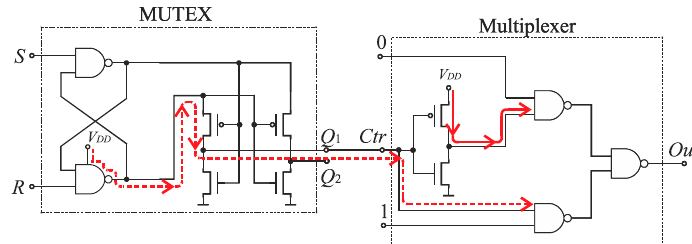
Figure 28. Asymmetrical control of channels (0 and 1) of multiplexer.